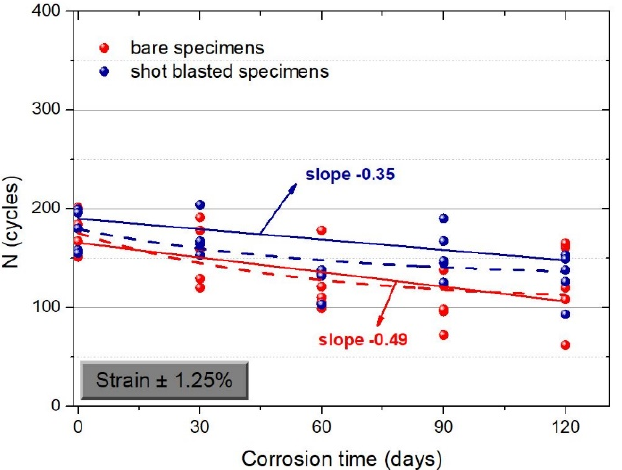
Figure 7. Fitting curves of number of cycles in function with corrosion time for imposed deformation ±1.25%.